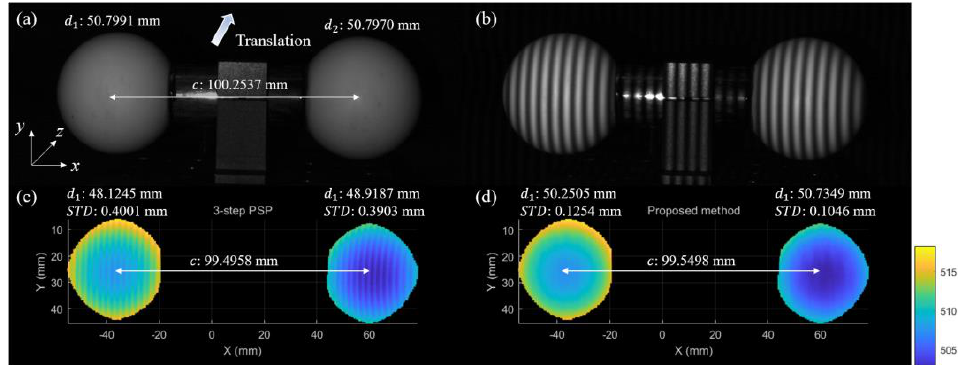
Figure 7. Measurement results of two standard spheres in actual FPP system. Symbol d represents diameter, c represents center distance. ( a ) Standard spheres translated in-depth direction to be tested. ( b ) One of deformed fringe patterns. ( c , d ) Reconstructed results of three-step PSP and proposed method, respectively.